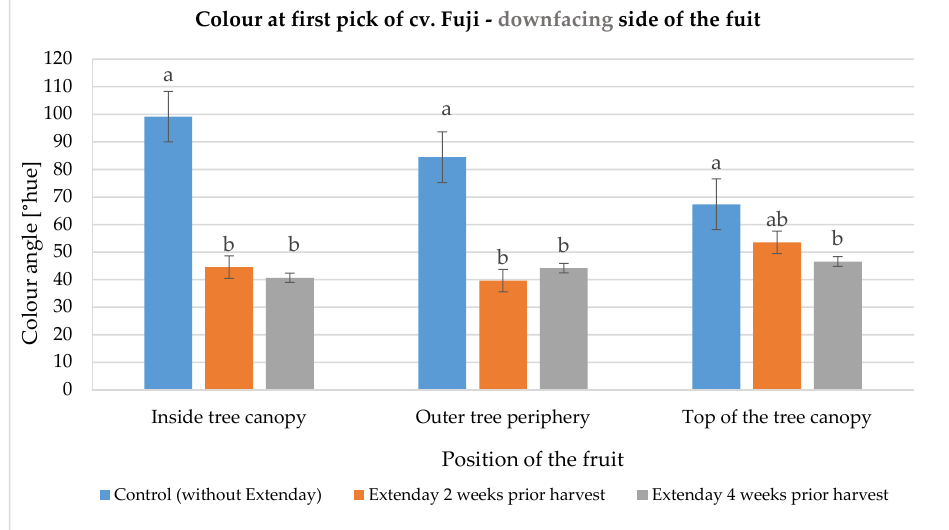
Figure 11. Colour of the down facing side of the cv. Fuji fruit at first pick as affected by the timing of reflective mulch. (Treatments with different letter for the same position of the fruit within the same pick are statistically different ( p < 0.05) (n = 60 fruit per treatment per position).